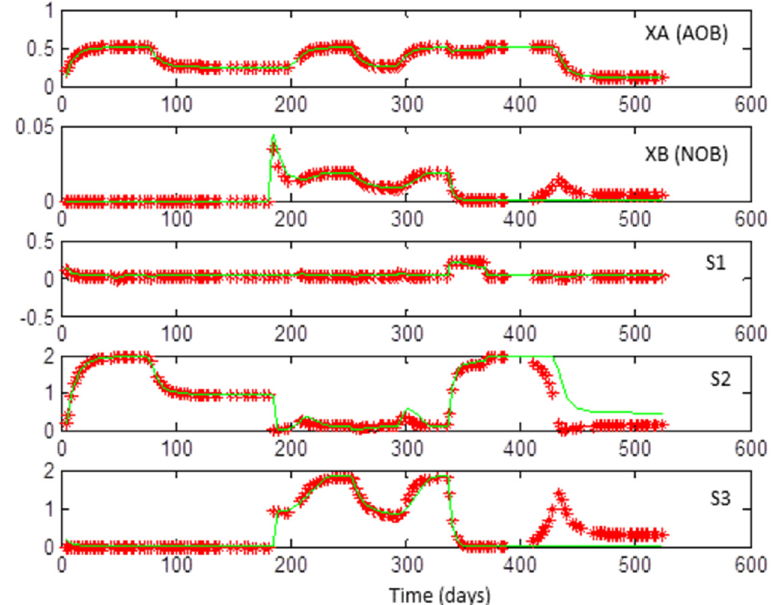
Figure 2. Simulations of main outputs of models #1 and #2 in appropriate concentration units (obtained with the mean values of the optimized parameters given in Table 1 for model#1 and Table 4 for model #2, the mean values over the 520 values were used as well for parameters with bimodal distributions). X A , X B , S 1 (a negative part for the y -axis was considered for clarity), S 2 and S 3 concentrations from the top to the bottom, predictions of model #1 in red crosses, predictions of model #2 in green where X A = X 1 + X 2 and X B = X 3 + X 4 .